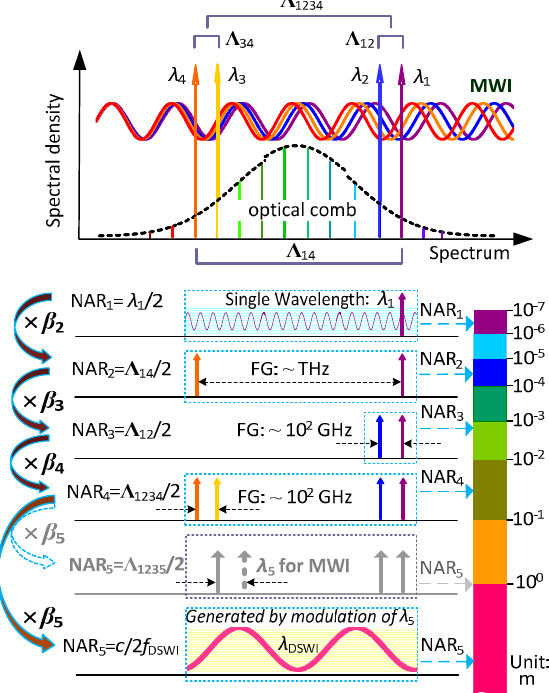
Figure 2. Schematic diagram for non-ambiguity range (NAR) extension. Λ : virtual synthetic wavelength; FG: frequency gap; NAR i : i -th order NAR.